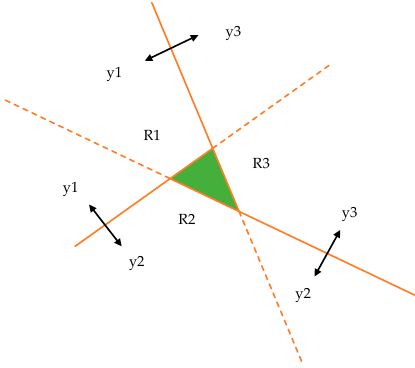
Figure 5. Ambiguities in the one-versus-one approach. The green area represents the ambiguous part.